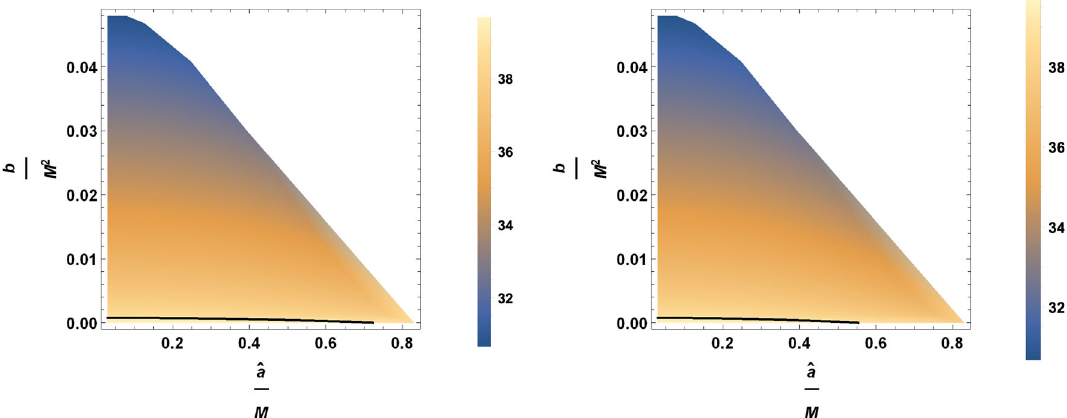
Fig. 21 For the left panel the inclination angle is 90 ◦ and for the right panel the inclination angle is 17 ◦ . The black solid lines correspond to